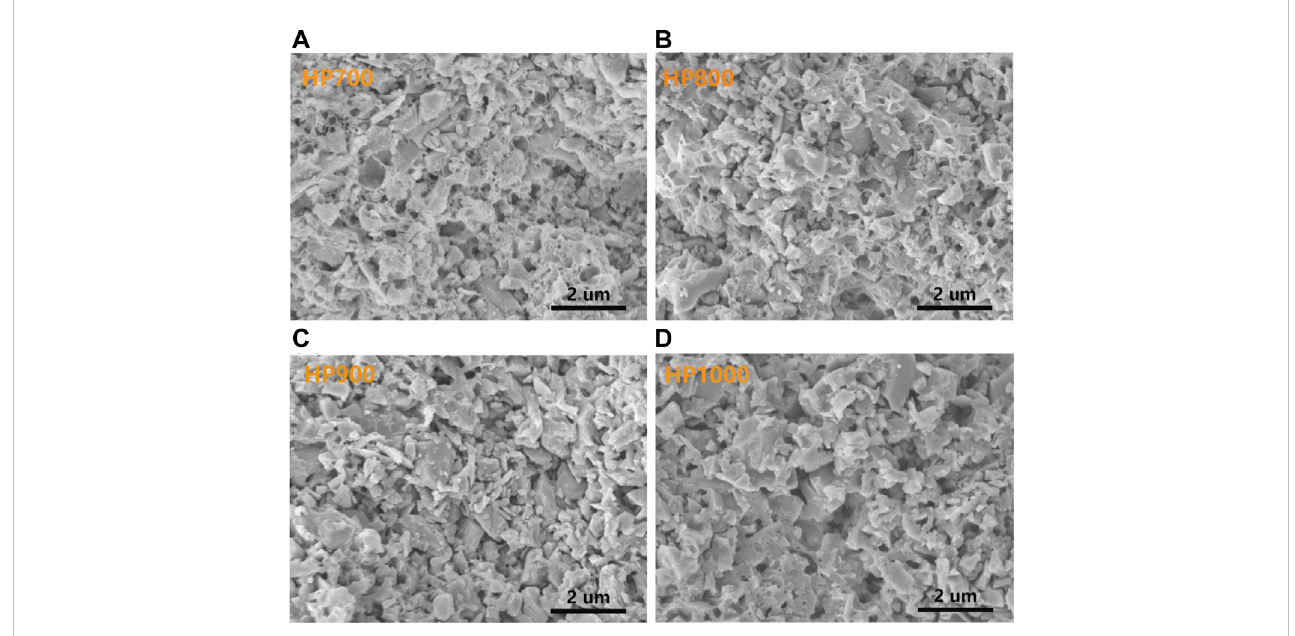
FIGURE 3 SEM images of SiC/BBSZA composites sintered at different temperatures etched with strong acids and alkalis: (A) 700 ° C, (B) 800 ° C, (D) 900 ° C, and (D) 1,000 ° C.